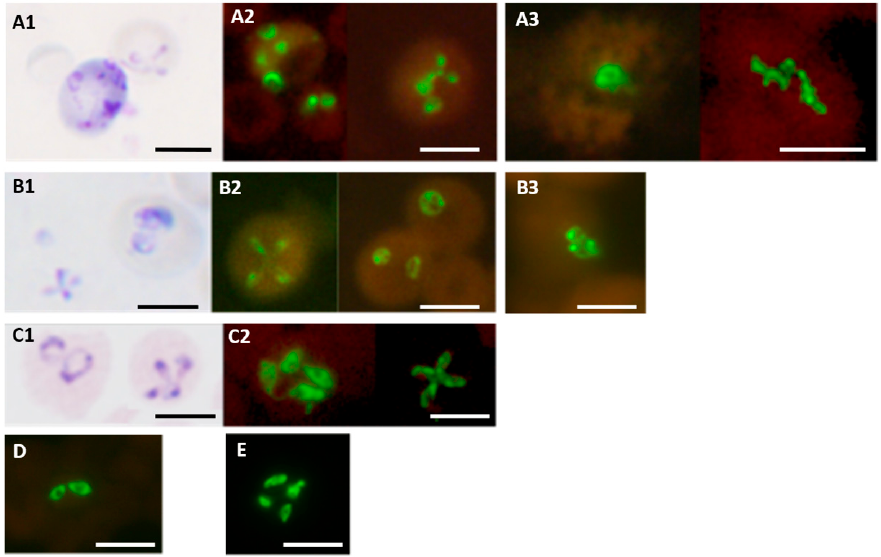
Figure 6. Babesia genus-specific FISH test on different Babesia species. Parasites stained with Giemsa in smears used for FISH tests are shown in the case of ( A1 ) B. microti ; ( B1 ) B. duncani ; and ( C1 ) B. divergens. Fluorescence observed in FISH tests on corresponding smears from the same preparations are shown in ( A2 ) B. microti (from hamster blood); ( B2 ) B. duncani (from hamster blood); ( C2 ) B. divergens (from culture). Other FISH test results on smears of ( D ) B. bovis (from bovine blood); ( E ) B. bigemina (from bovine blood) are also shown. Fluorescence in FISH tests on blood smears from two patients with the infecting species confirmed by DNA sequencing are shown in ( A3 ) for B. microti and ( B3 ) for B. duncani . Scale bars represent approximately 5 µ m. Reproduced with permission under the creative commons license from Reference